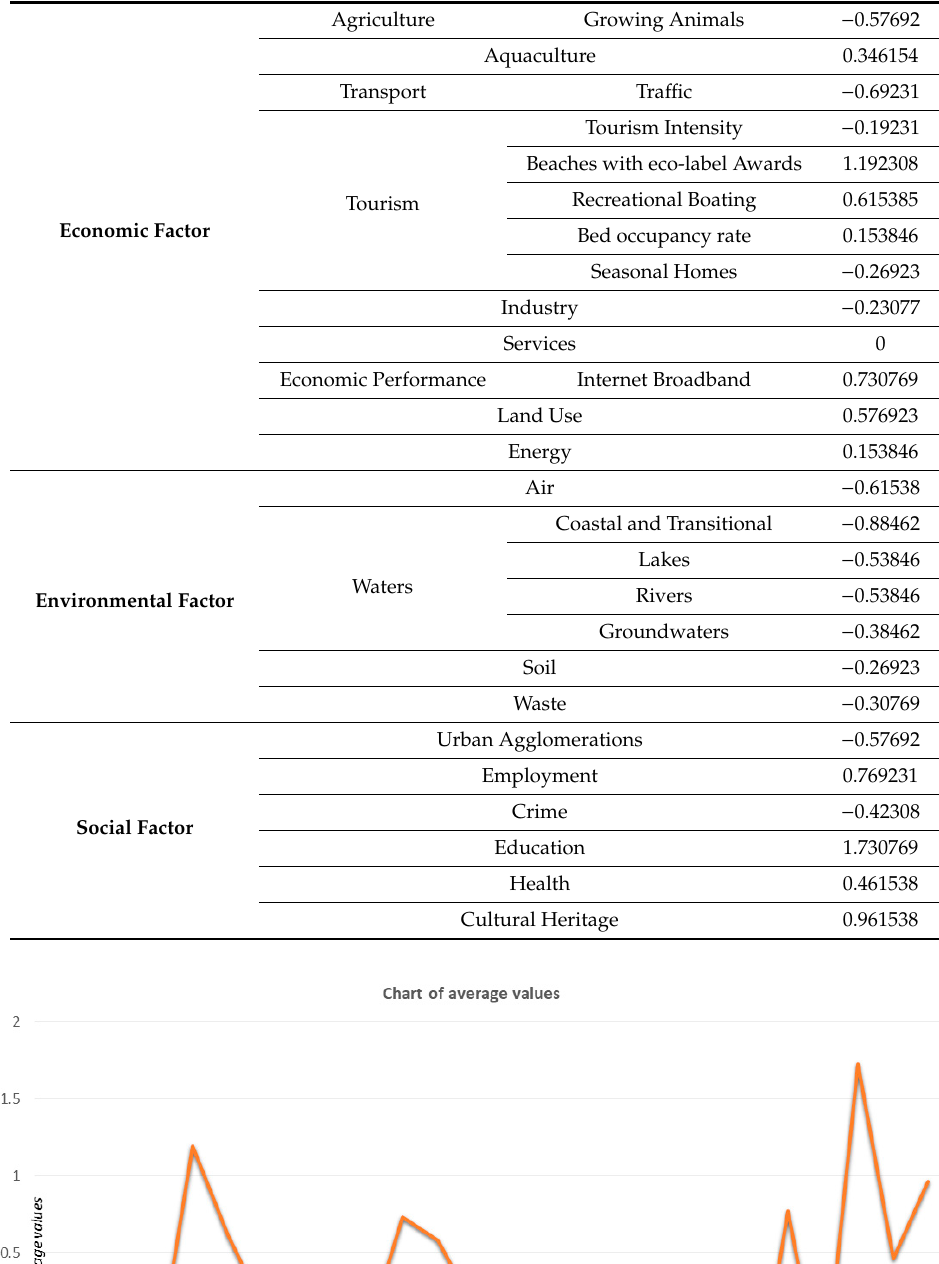
Table 3. Average values of economic, social, and environmental indicators (author).